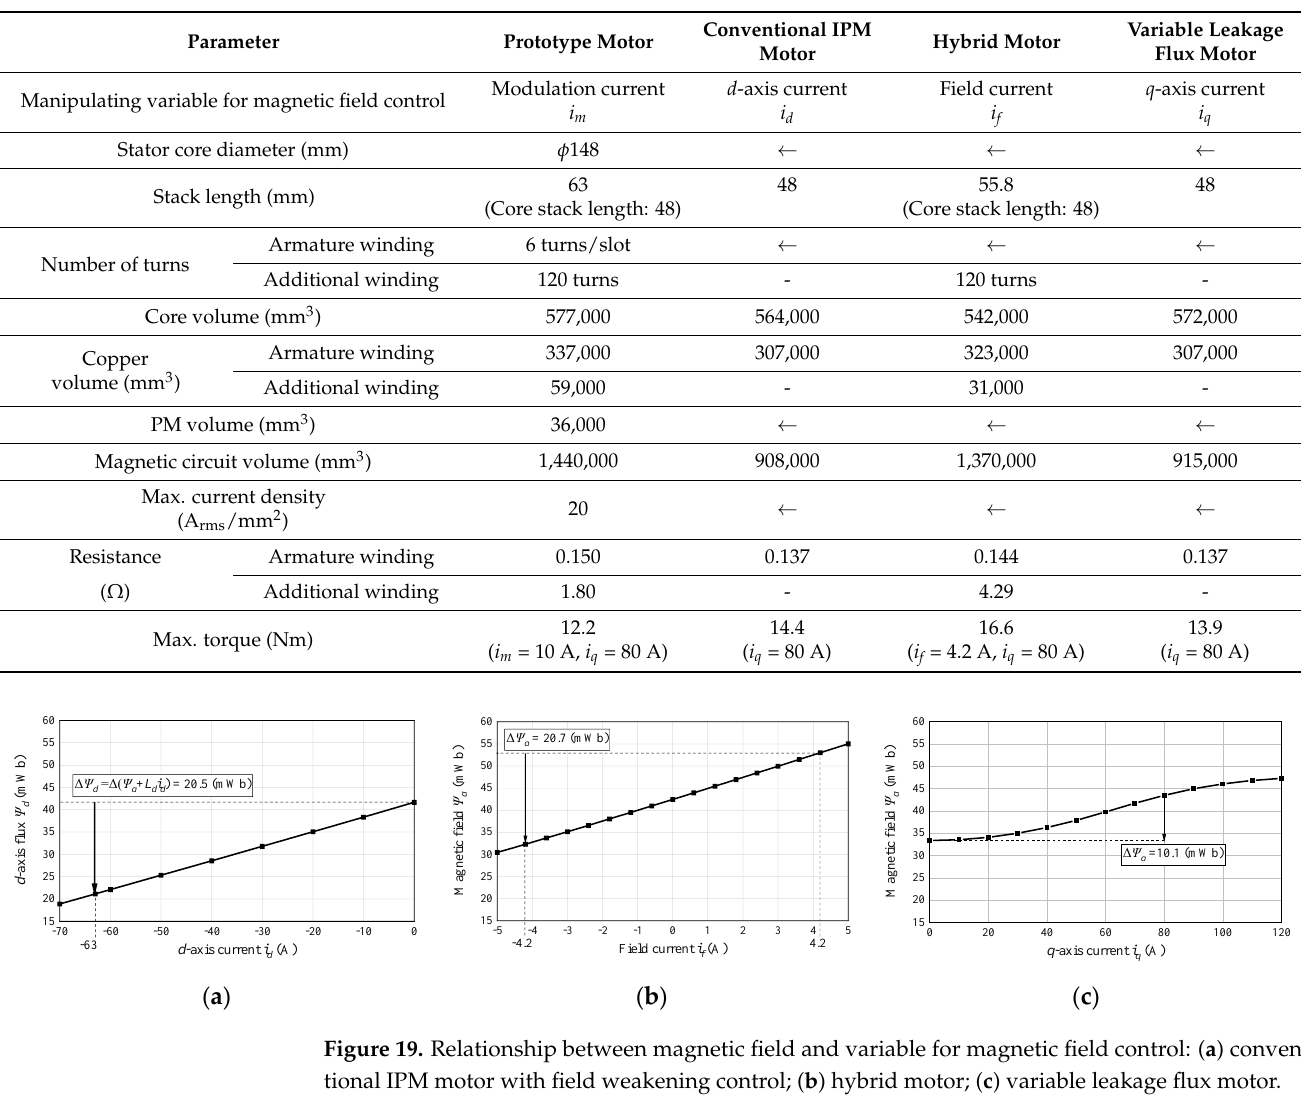
Table 4. Specifications of compared motors.